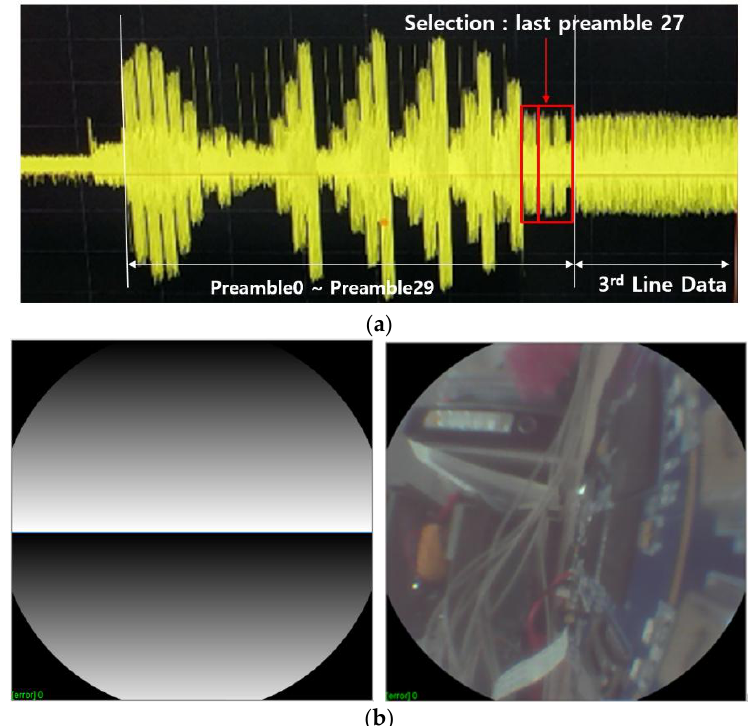
Figure 10. Operation results of the proposed system: ( a ) Output of the analog front end (AFE) amplifier; ( b ) Image results received by the CEHBC system: (left) Image data using a known pattern, (right) Image data using the CMOS image sensor.